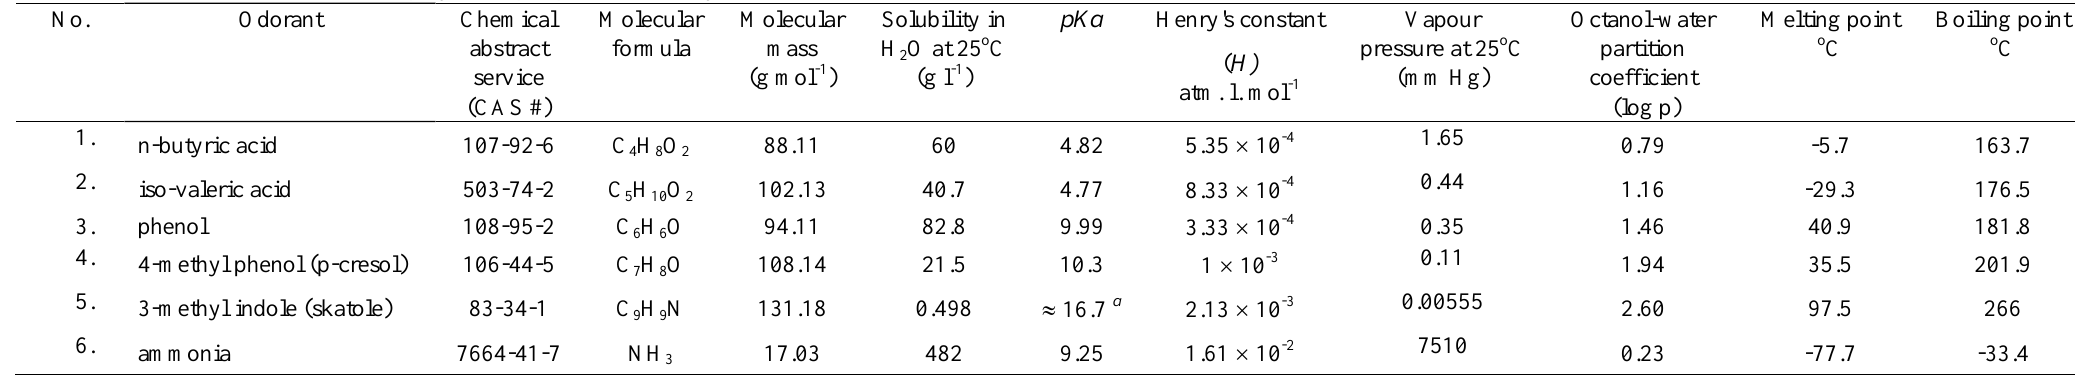
Table 1. Chemical and physical properties of key odorants. No.